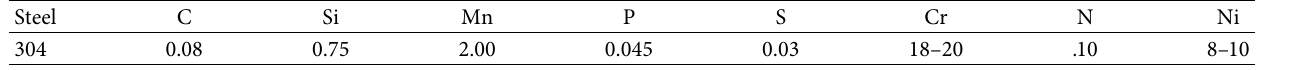
Table 1: Chemical composition of the used stainless steel